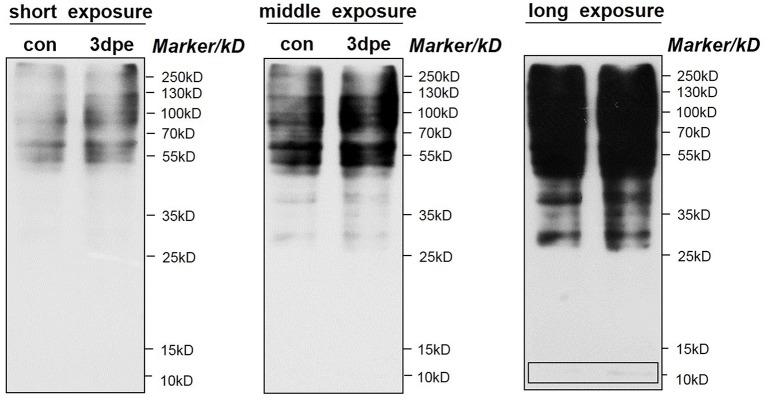
Western blotting of pan-acetylation during intestine regeneration in sea cucumbers. Cell lysate samples contain 20 μg of total protein per lane. Proteins with a molecular weight of ~10 kb are likely histone family member.